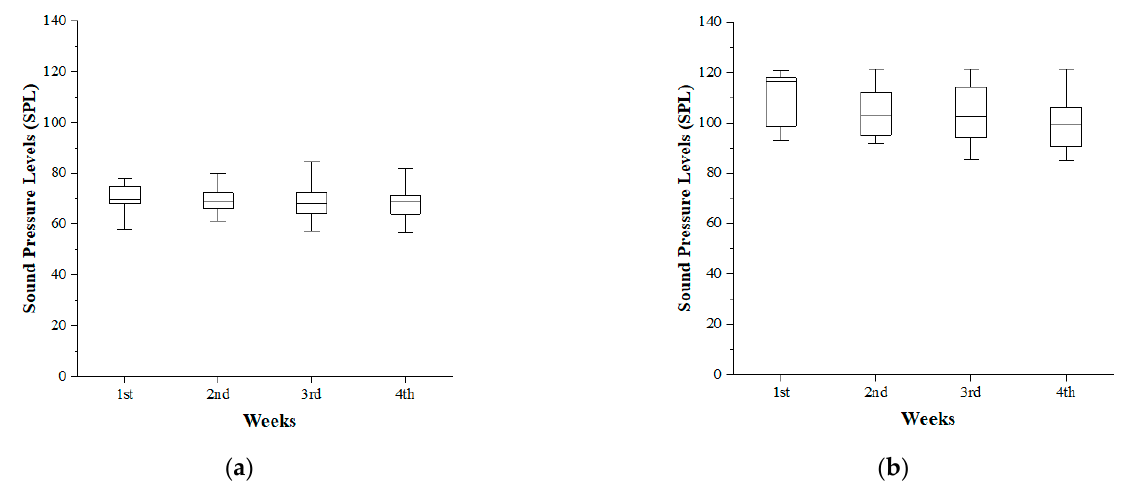
Figure 3. Box-and-whisker plot of mean preferred listening levels for 4 weeks: Average Z-weighted equivalent sound pressure levels (LZeq) ( a ) and maximum C-weighted peak sound level (LCpeak) ( b ).